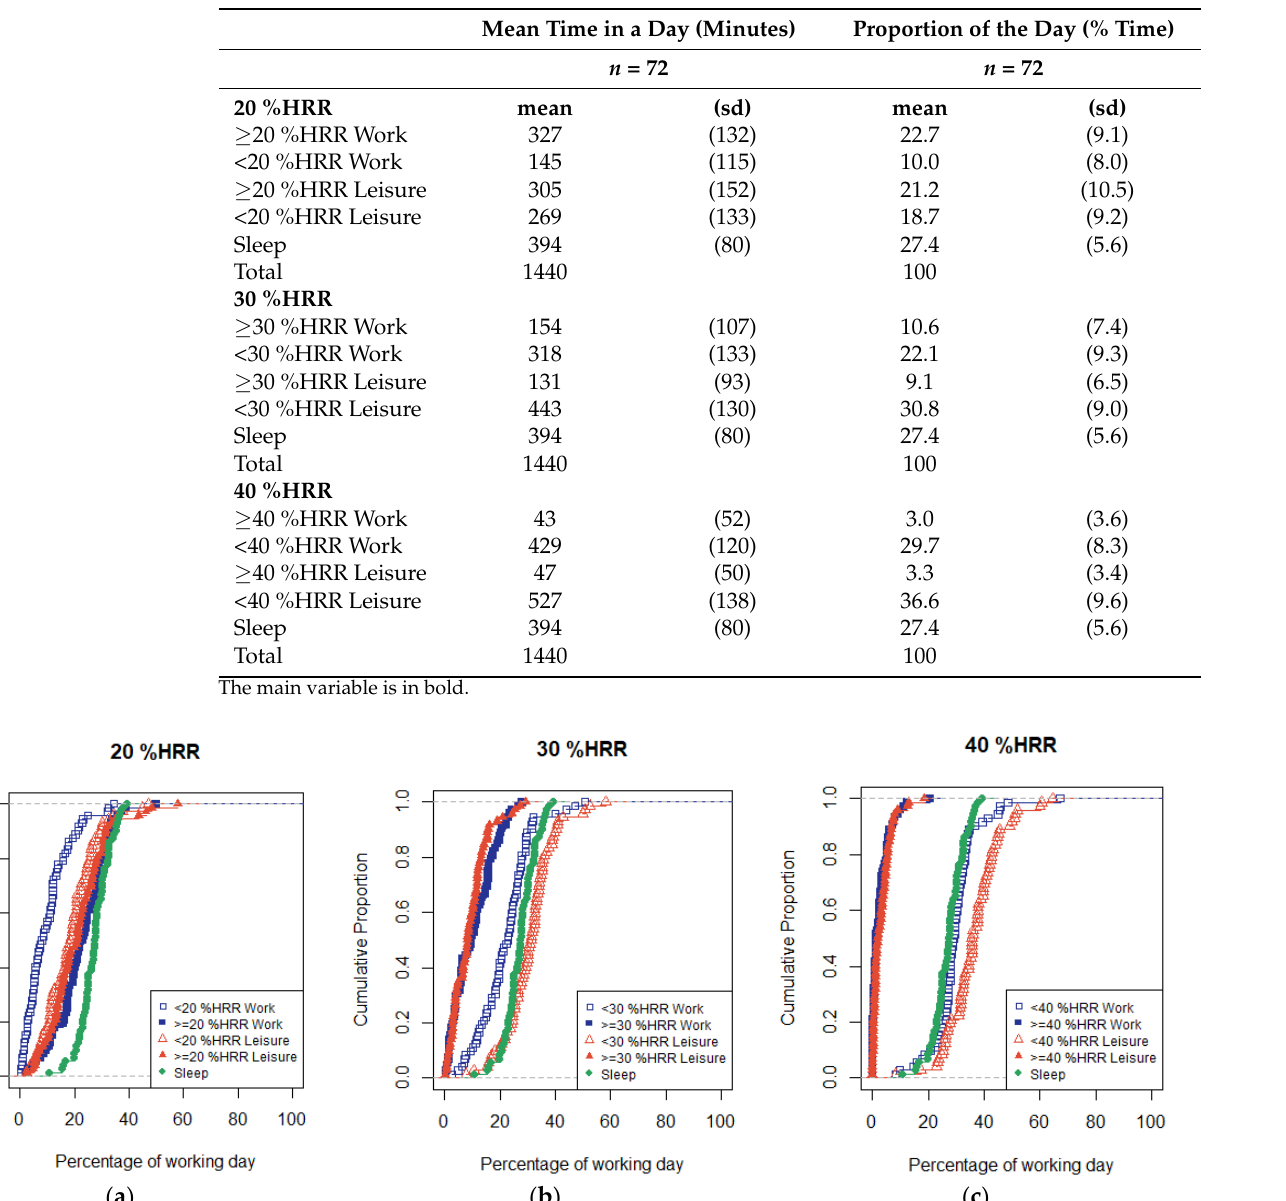
Figure 2. Cumulative distribution functions for the participants’ ( n = 72) percentage of time in sleep and in activity below and above ( a ) 20 %HRR, ( b ) 30 %HRR, and ( c ) 40 %HRR during work and leisure. and Table 2. Averages of time and percentage of time during a 24 h day spent in the physical activity categories and in sleep.